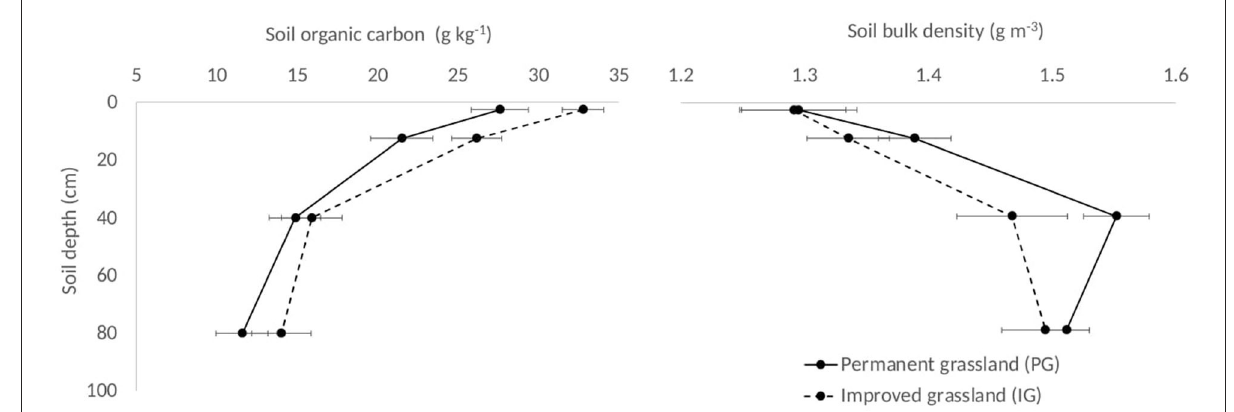
FIGURE2 Soil carbon content (g kg − 1 ) and soil bulk density (g cm − 3 ) of soil layers in two grassland areas at Hacienda San Jose, Colombia.